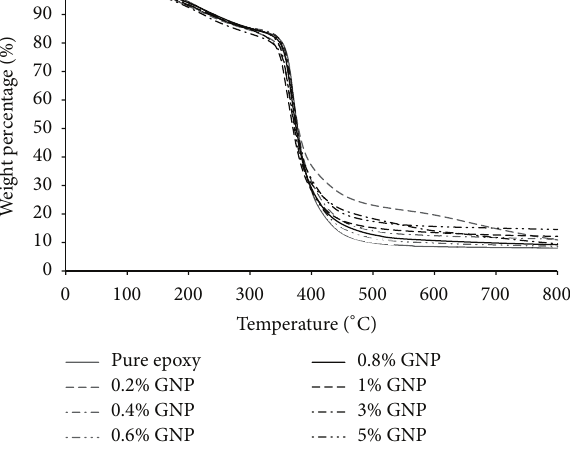
Figure 8: TGA thermograms of GNP filled epoxy composites.